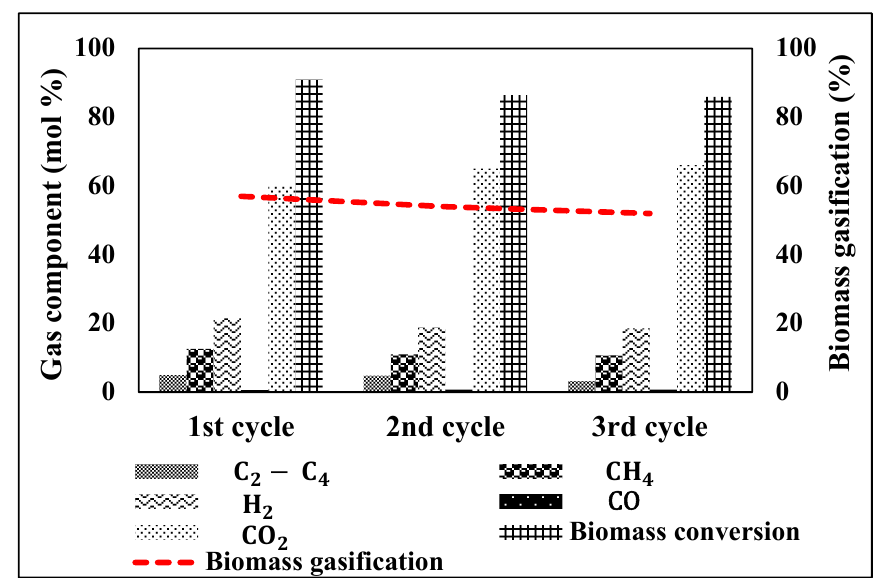
Figure 9. Influence of NiFe 2 O 4 recycling on the eucalyptus wood chips SCWG at 450 °C, using 2 g of catalyst and reaction time of 60 min.